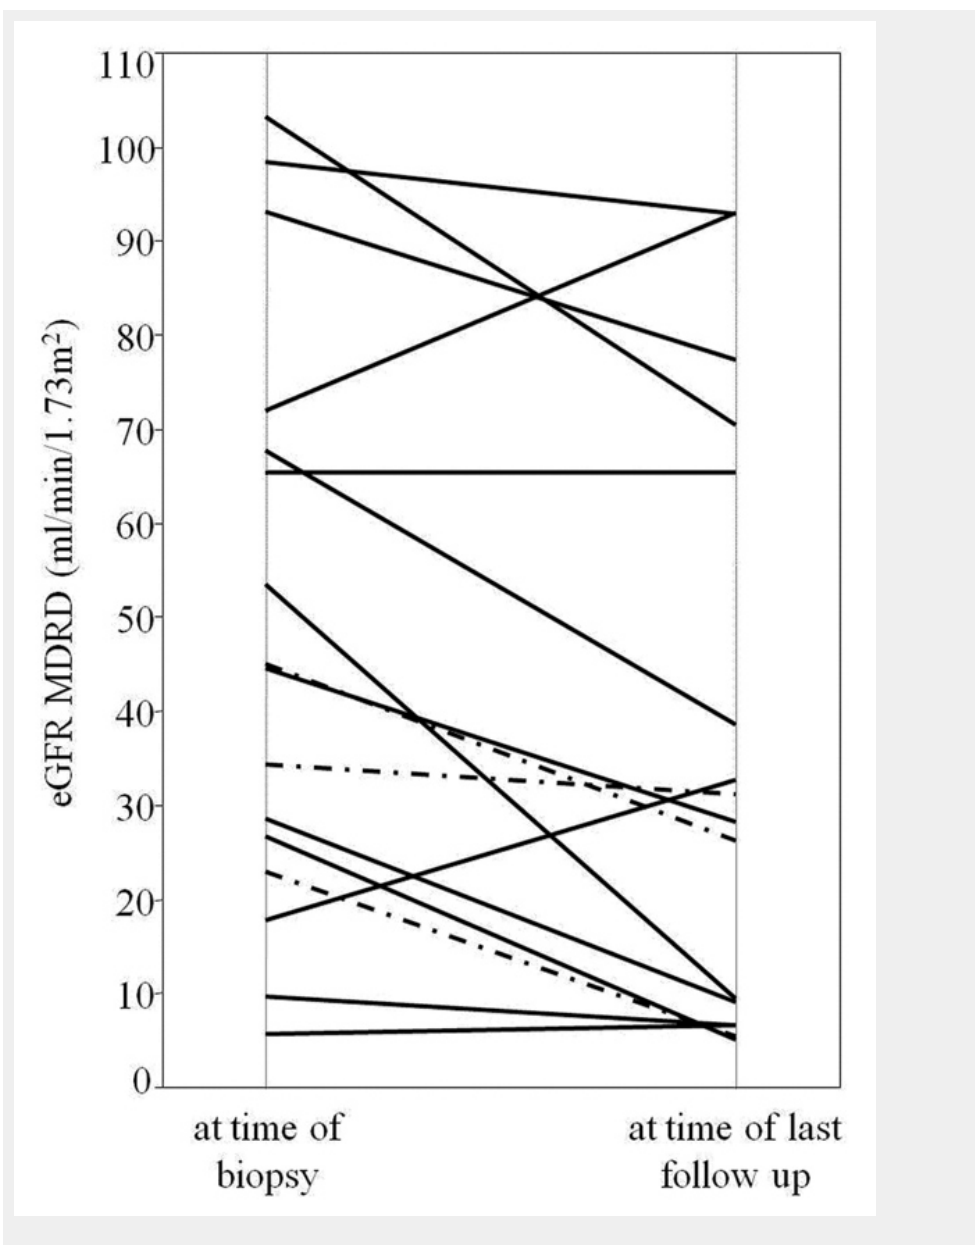
Figure 2 Each solid line shows the course of eGFR of a patient with immunosuppressive treatment, each dashed line shows the course of eGFR of a patient without immunosuppressive